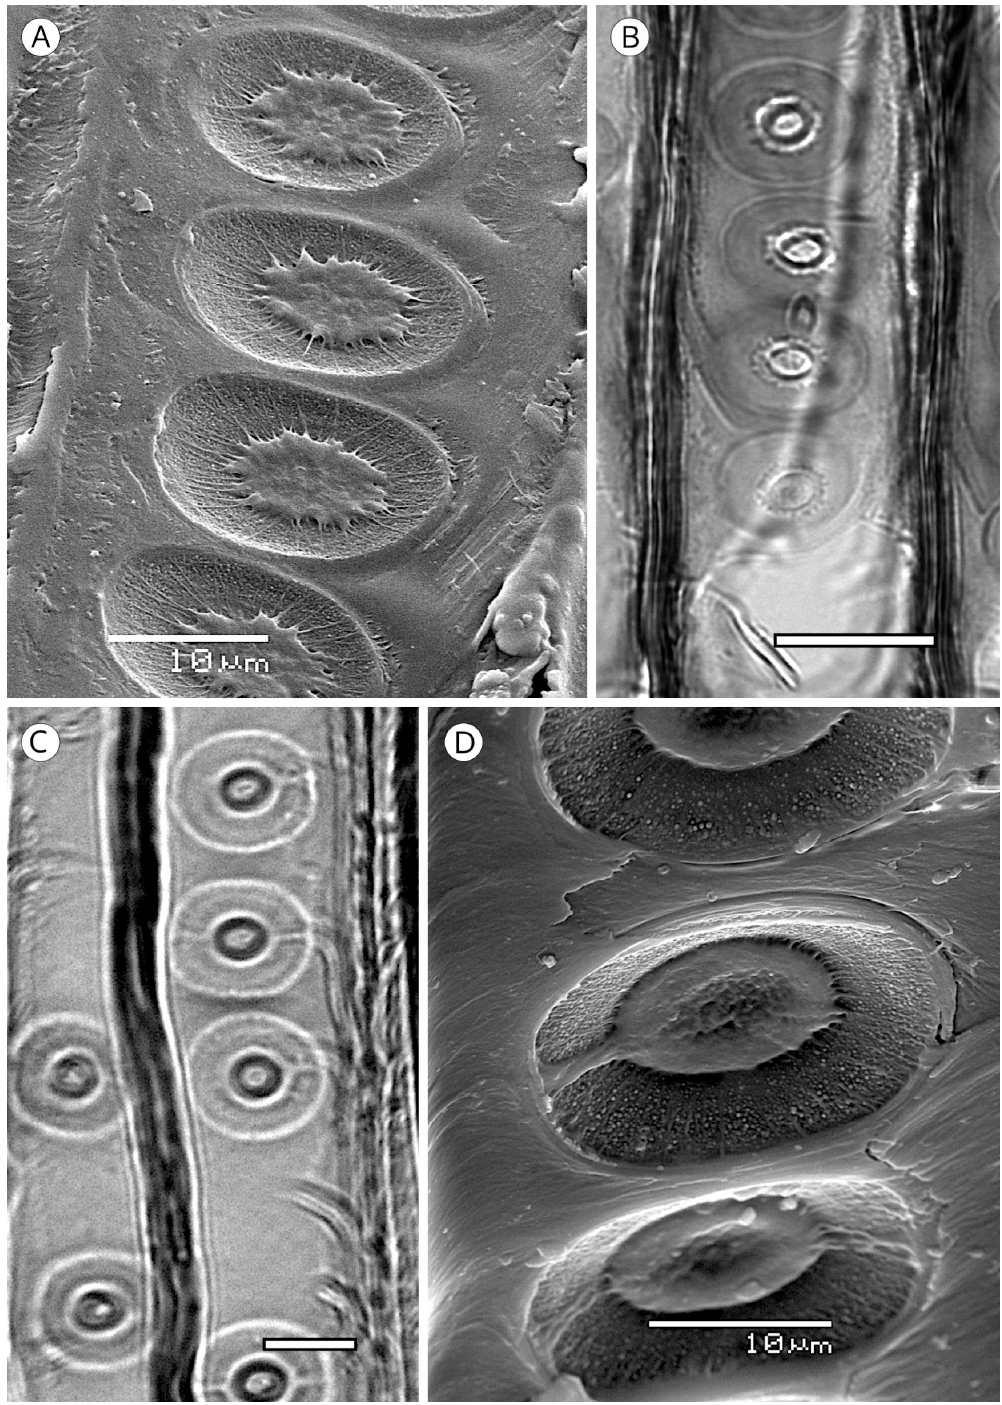
Figure 15. Scalloped torus and extensions. ( A ) Scalloped torus in Cedrus atlantica (Endl.) Manetti ex Carrière (SEM); ( B ) Scalloped torus in Cedrus atlantica (Endl.) Manetti ex Carrière; ( C ) Torus extensions in Abies magnifica A.Murray bis; ( D ) Torus extensions in Abies pinsapo Boiss. (SEM). Scale bars. ( B , C ) = 25 μ m.